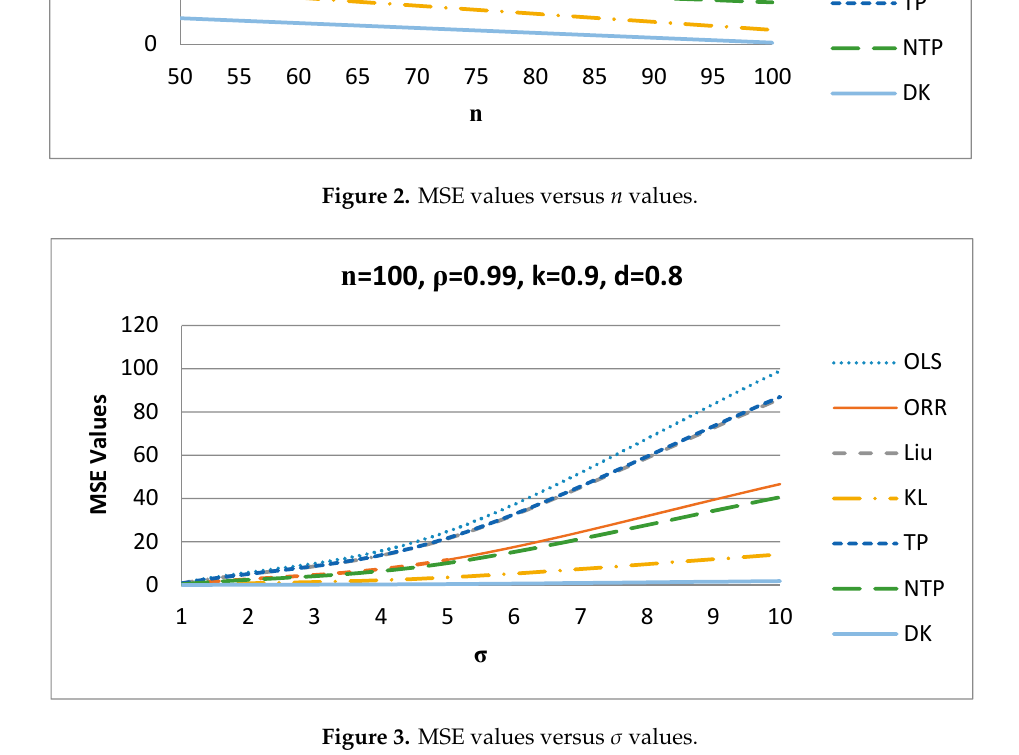
Figure 3. MSE values versus σ values.